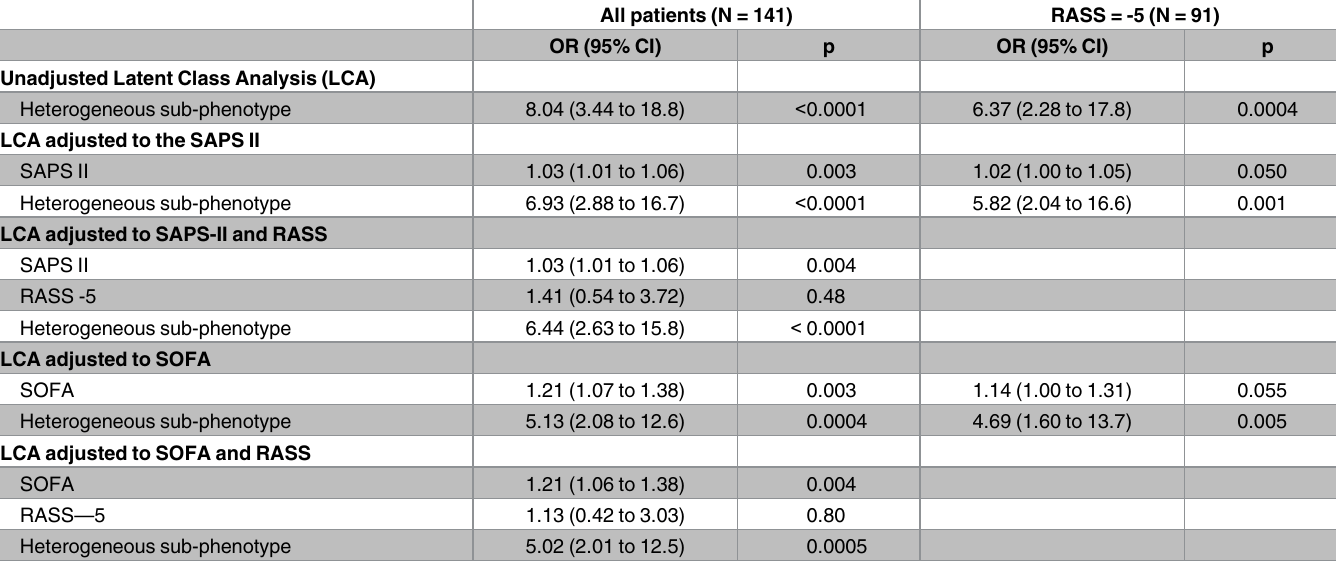
Table 4. Association between heterogeneous sub-phenotype and 28-day